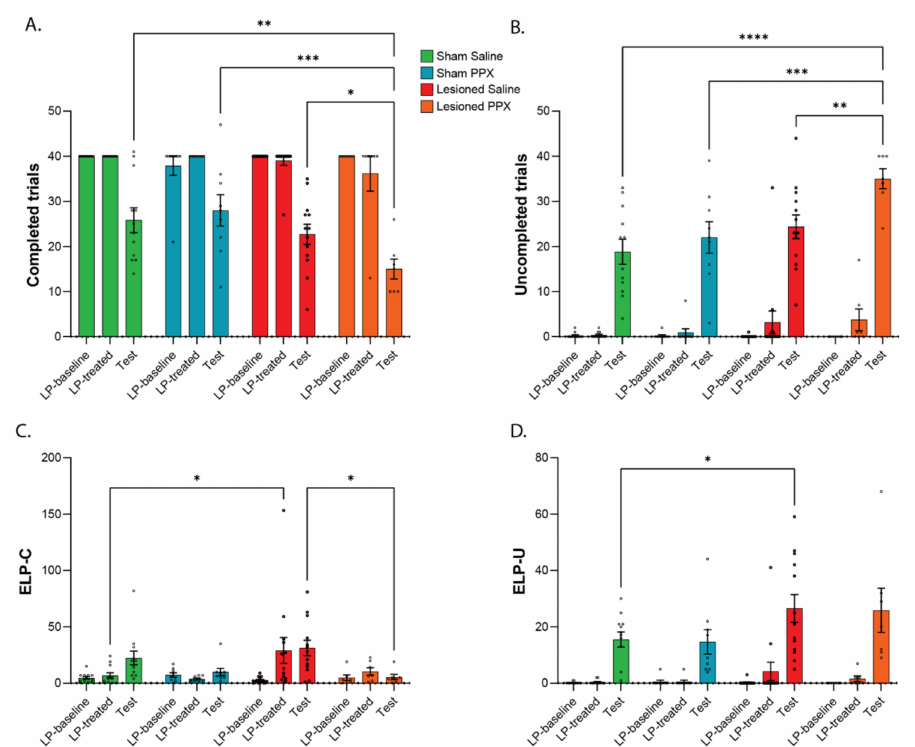
Figure 4. Post training signal attenuation task (experiment 2). ( A ). Number of completed trials during the different stages of the experiment (LP: Lever-press). ( B ). Number of uncompleted trials during the different stages of the experiment. *, p < 0.05; **, p < 0.01; ***, p < 0.001; **** p < 0.0001. ( C ). Number of extra lever-press followed by magazine entry (extra lever-presses in completed trials; ELP-C). ( D ). Number of extra lever-press not followed by magazine entry (extra lever-presses in uncompleted trials; ELP-U). *, p <